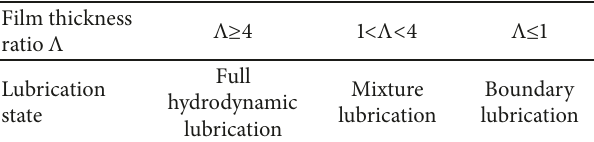
Table 4: The lubrication state of sliding bearings with different film thickness